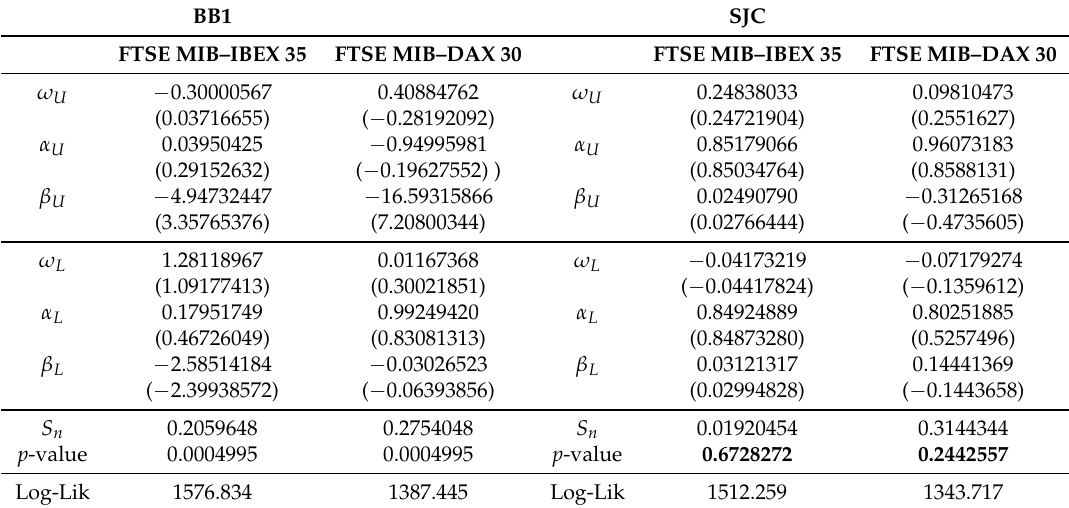
Table 4. Fitted coefficients, Cramér–von Mises test statistic (t.s.), and log-likelihood for the BB1, and for the Symmetrized Joe-Clayton (SJC) copulas with dynamic as in Equation (6).